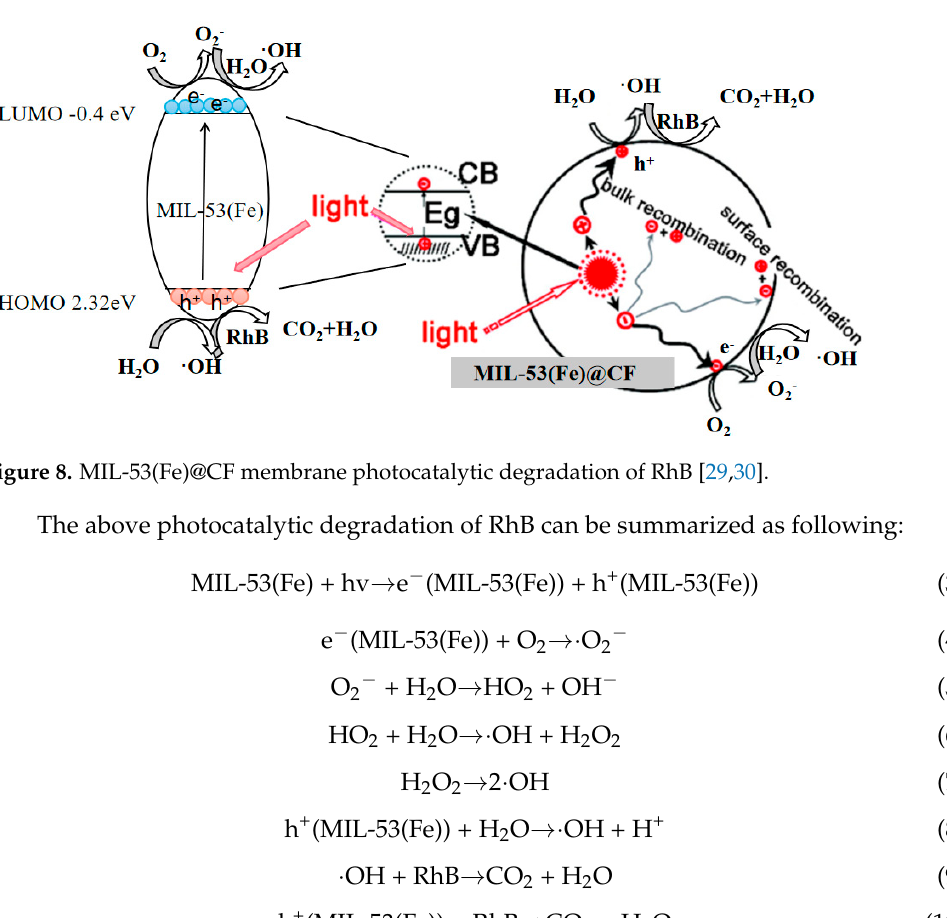
Figure 8. MIL-53(Fe)@CF membrane photocatalytic degradation of RhB 29.